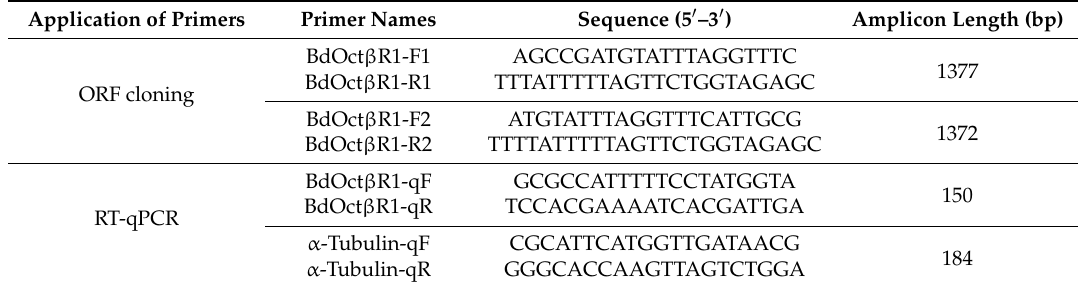
Table 1. Primers used for cloning; quantitative reverse transcription PCR (RT-qPCR) in Bactrocera dorsalis